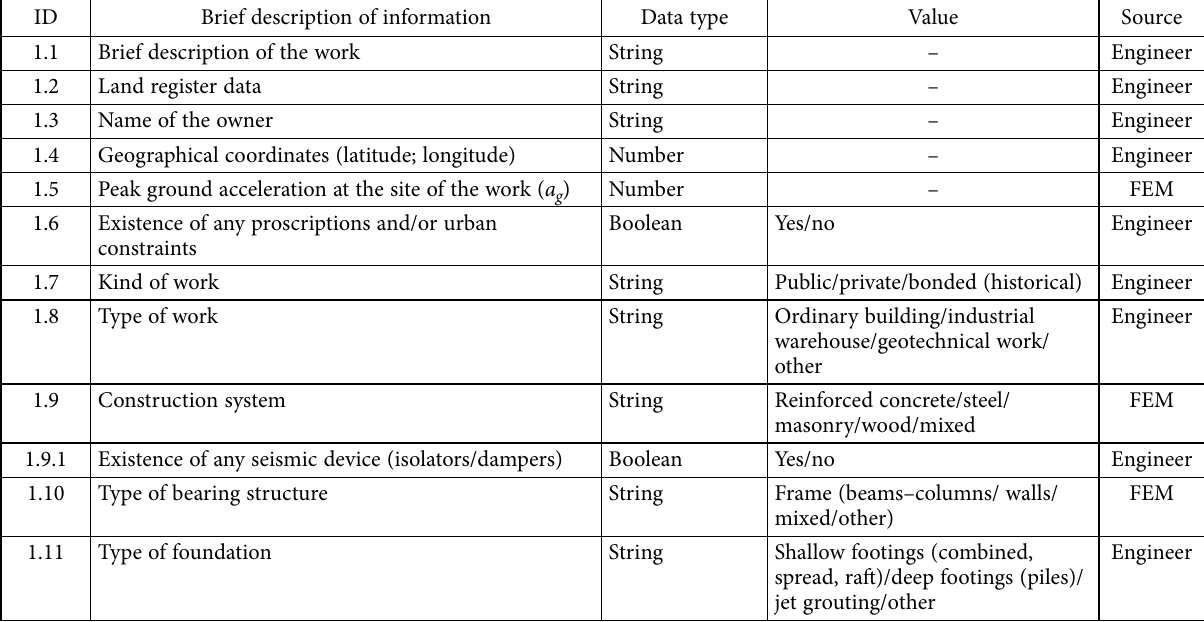
Table 4. All the information sought by building authorities in applications for seismic-authorisation